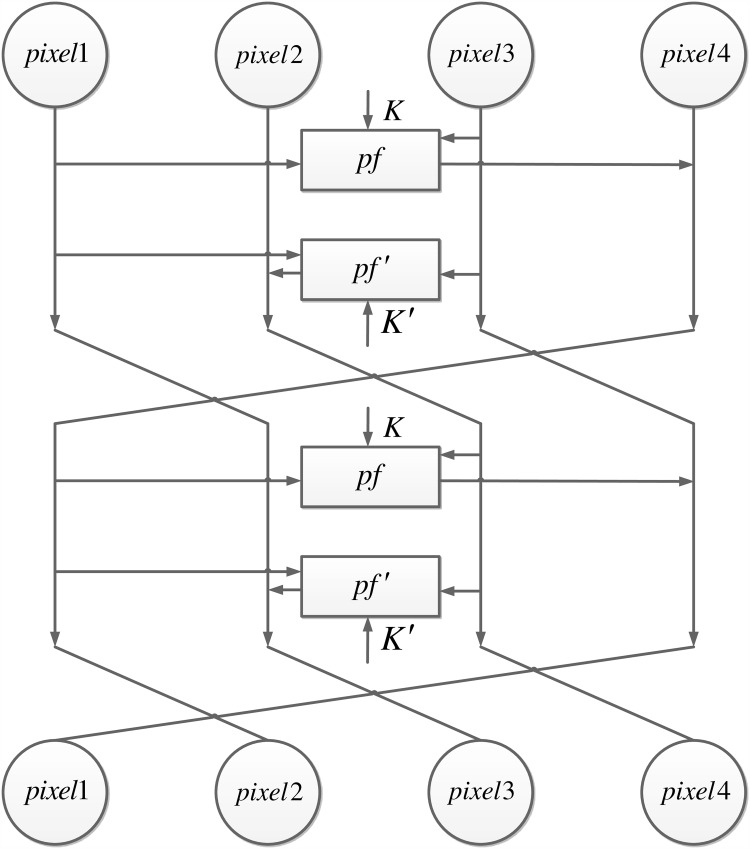
Two round 4-pixel Feistel structure of [33].